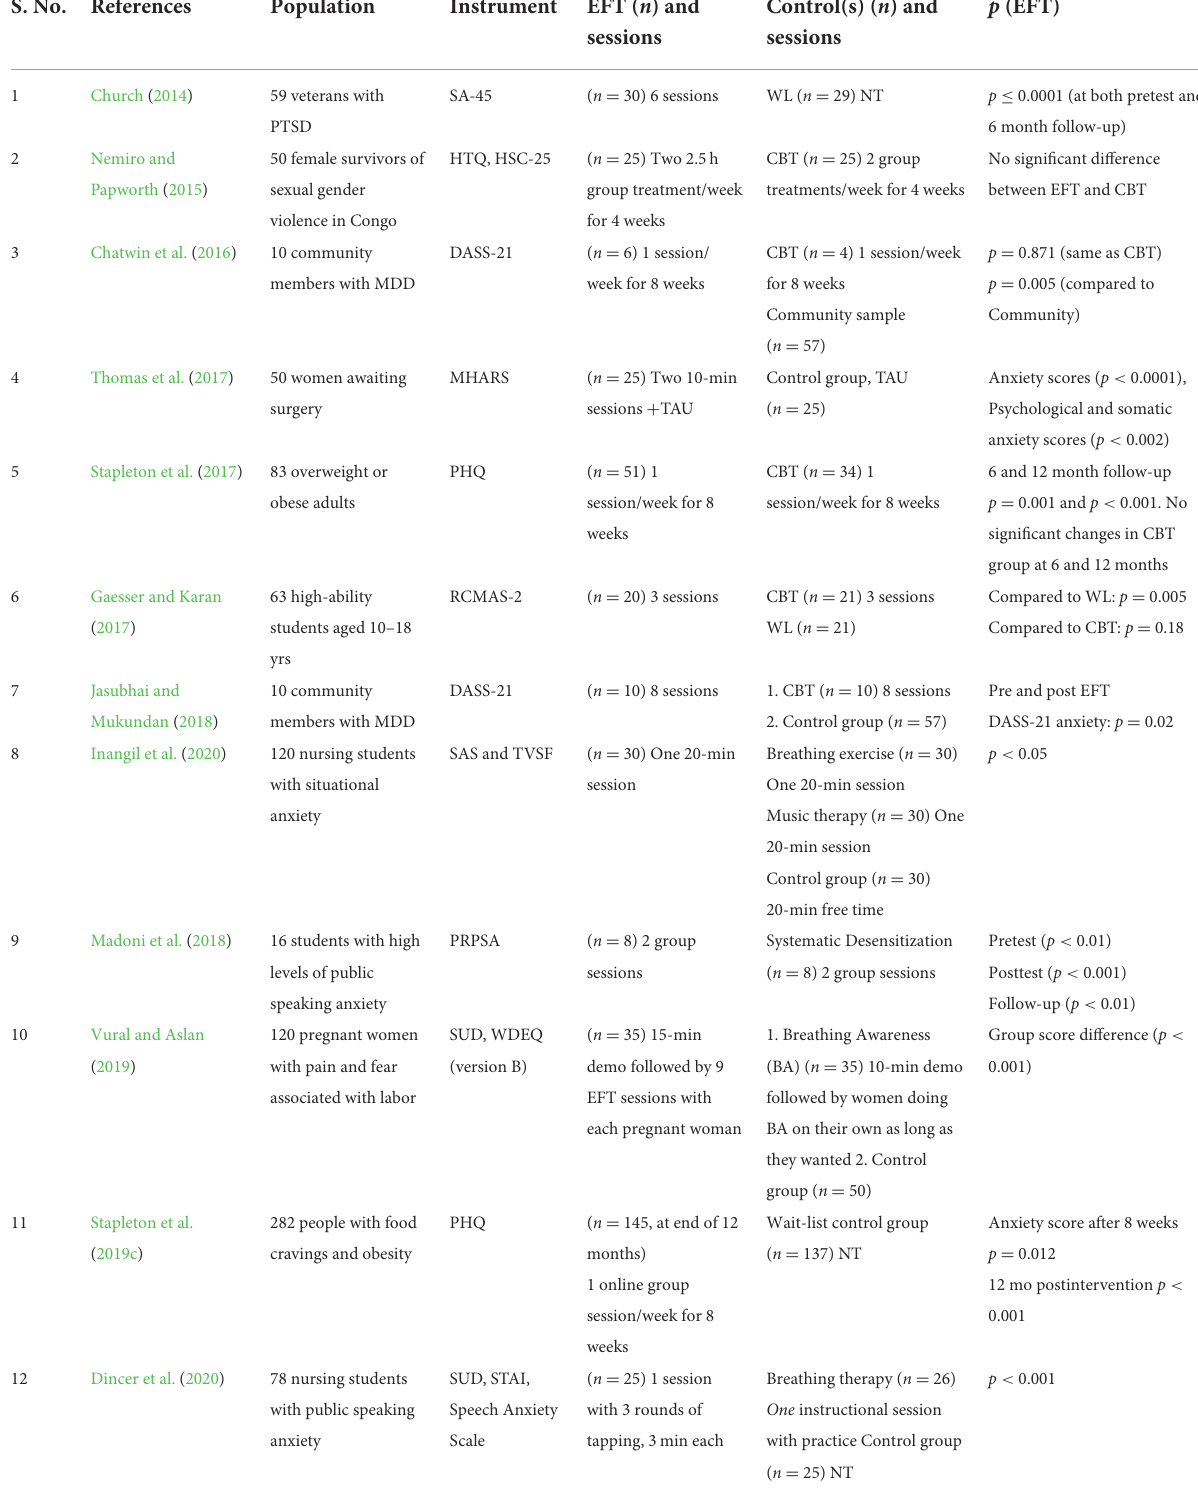
TABLE 3 Anxiety RCTs published since the Clond (2016)